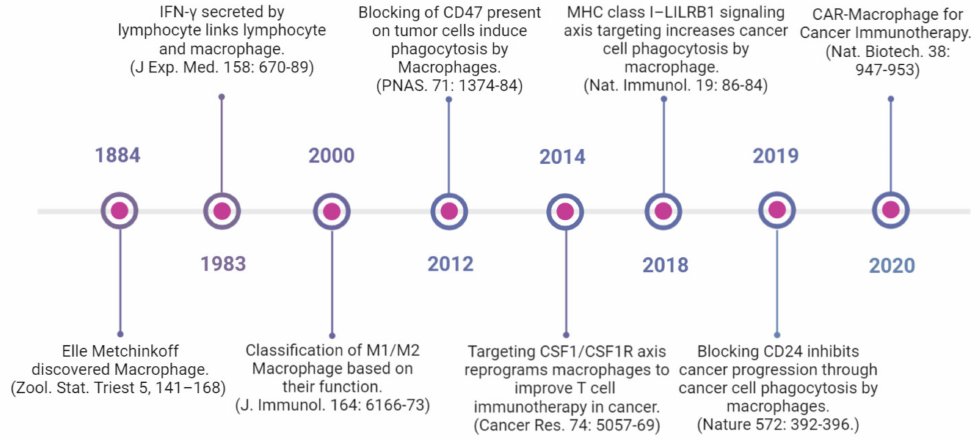
Figure 3. Timeline showing advancements in macrophage research and their therapeutic